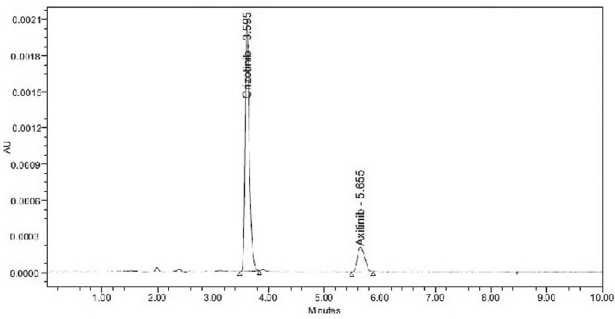
FIGURE 4 - Chromatogram of LQC.